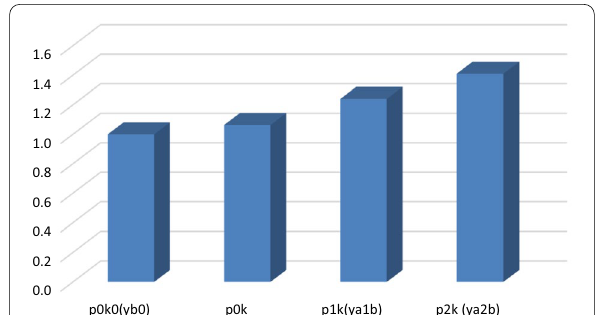
Fig. 3 Synergistic effect of P and K